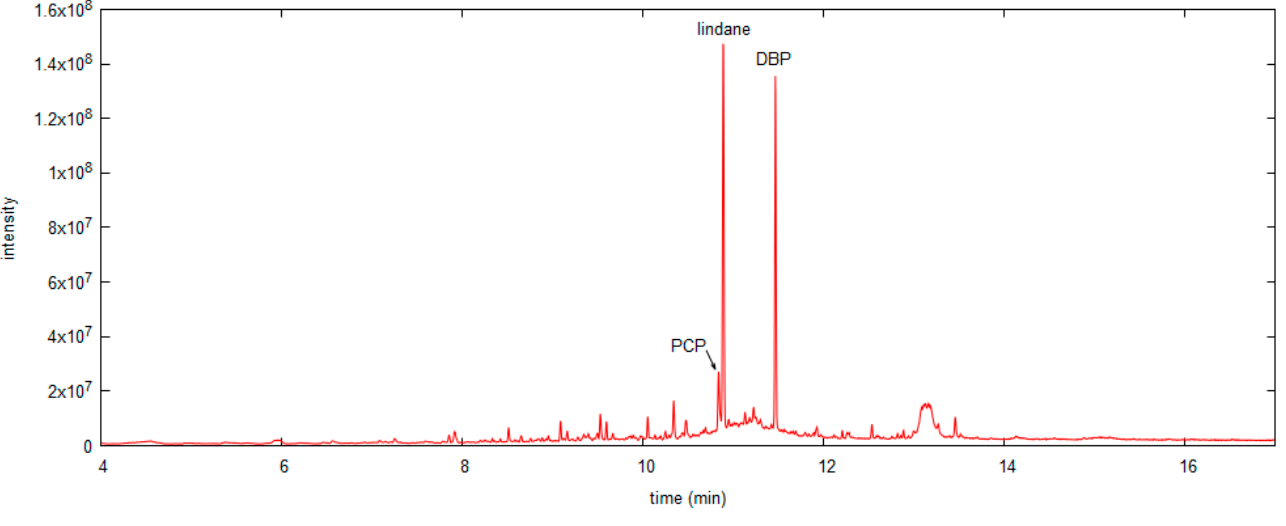
Figure 8. HS SPME chromatogram of OBJ3: PCP, lindane and dibutyl phthalate (DBP) were identified. Figure 8. HS SPME sampling was done in the central drawer of